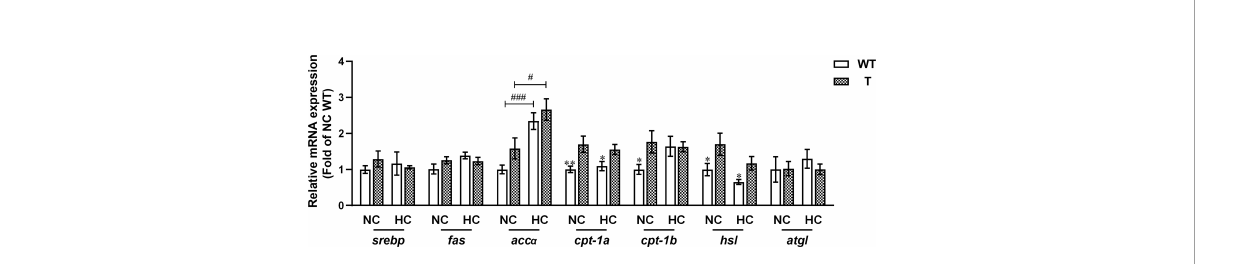
FIGURE 9 Expression levels of genes involved in lipid metabolism in the liver of T and WT common carp (n = 6). * and ** indicate a signi fi cant difference ( P < 0.05 and P < 0.01, respectively) in different strains at same dietary starch content. # and ### indicate a signi fi cant difference ( P < 0.05 and P < 0.001, respectively) in the same strain with different dietary starch